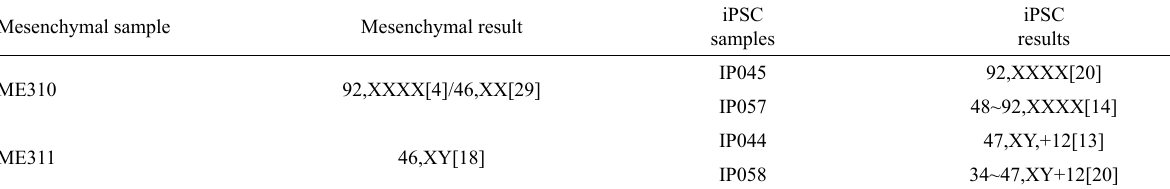
Table 2 ‒ Cytogenetic result before (mesenchymal) and after (iPSCs) reprogramming.